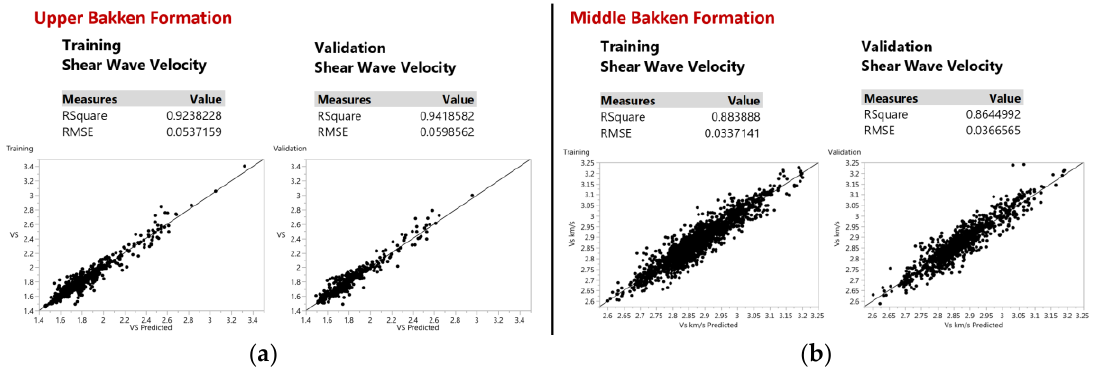
Figure 6. Flowchart process to obtain model to predict shear wave velocity for new wells.